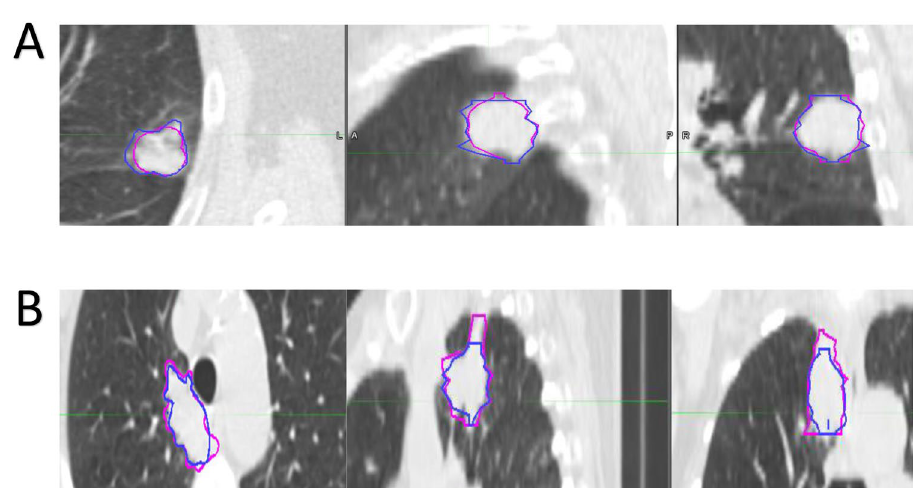
Figure 4. Case examples. Two examples (patient A and B) from the ‘NSCLC-Radiomics’ dataset are provided highlighting patients who had high Dice coefficients (DC) yet also had relatively high absolute differences in the shape feature ‘original_shape_Compactness2’ (A = Lung1-157, DC = 0.90, Difference = 0.15; B = Lung1-378, DC = 0.79, Difference = 0.12). Note blue = MAASTRO contour and pink = PMCC